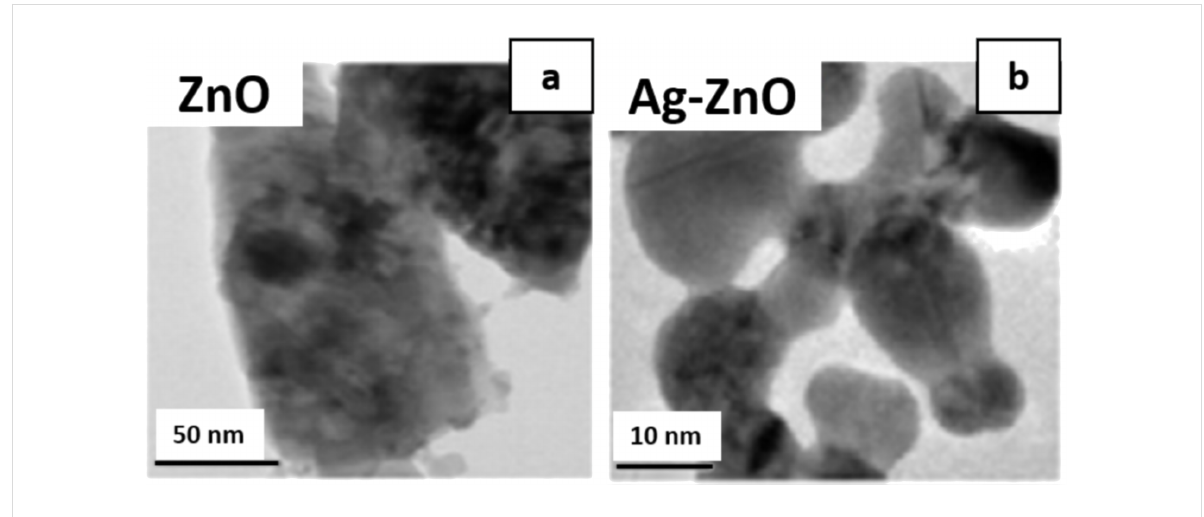
Figure 8: Transmission electron microscopy images for (a) pristine ZnO and (b) 2–3% Ag-doped ZnO. Figure 8a and Figure 8b were adapted from [61], J. Photochem. Photobiol. A, vol. 325, by J. Jayabharathi; A. Prabhakaran; V. Thanikachalam; M. Sundharesan,“Hybrid organic-inorganic light- emitting diodes: Effect of Ag-doped ZnO”, pages 88–96, Copyright (2016), with permission from Elsevier. This content is not subject to CC BY 4.0.